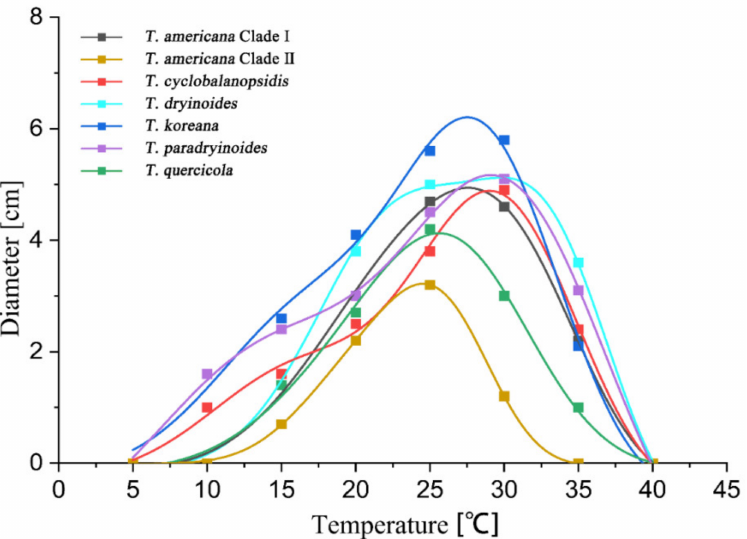
Figure 5. The effect of temperature on the mycelial growth rate of six Tubakia species on MEA. The averages of radial growth rate and temperatures were adjusted to a nonlinear regression curve through the Analytis GCAS model. Data points are the means of two independent experiments of three replicated Petri dishes. The formula of the nonlinear fitting curve is as follows: T .